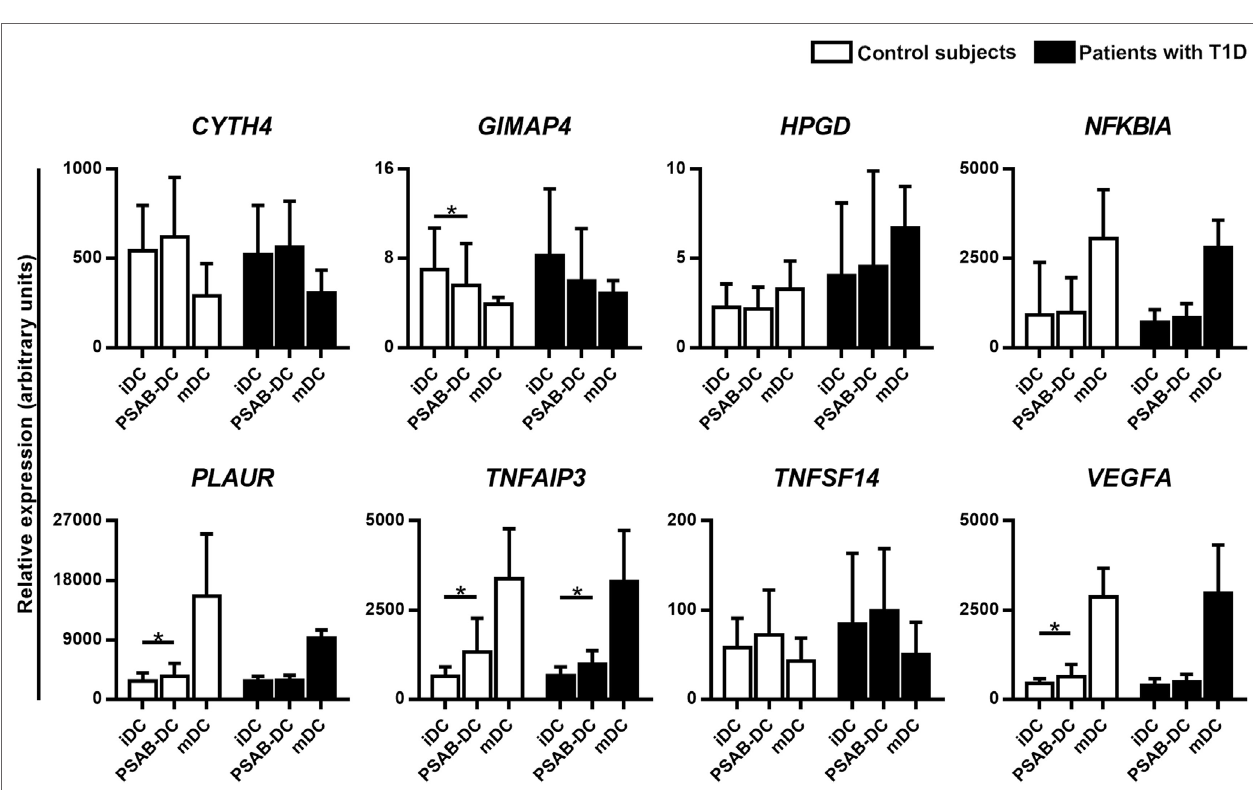
FigUre 6 | Quantitative RT-PCR validates the RNA-seq results. Relative gene expression of 8 selected targets in immature dendritic cells (iDCs), after phagocytosis of PSA-liposomes and PSB-liposomes (PSAB-DCs), and in mature dendritic cells (mDCs), analyzed by quantitative RT-PCR. Gene expression signals were normalized to GAPDH . Bars show the mean ± SD of gene expression in control subjects (white bars, n ≥ 3) and patients with type 1 diabetes (T1D) (black bars, n ≥ 4). Statistically significant differences were found when comparing the different conditions in the same group of subjects (* p < 0.05, Wilcoxon test), and differences were not found when comparing the same culture conditions between patients with T1D and control subjects (Mann–Whitney test).